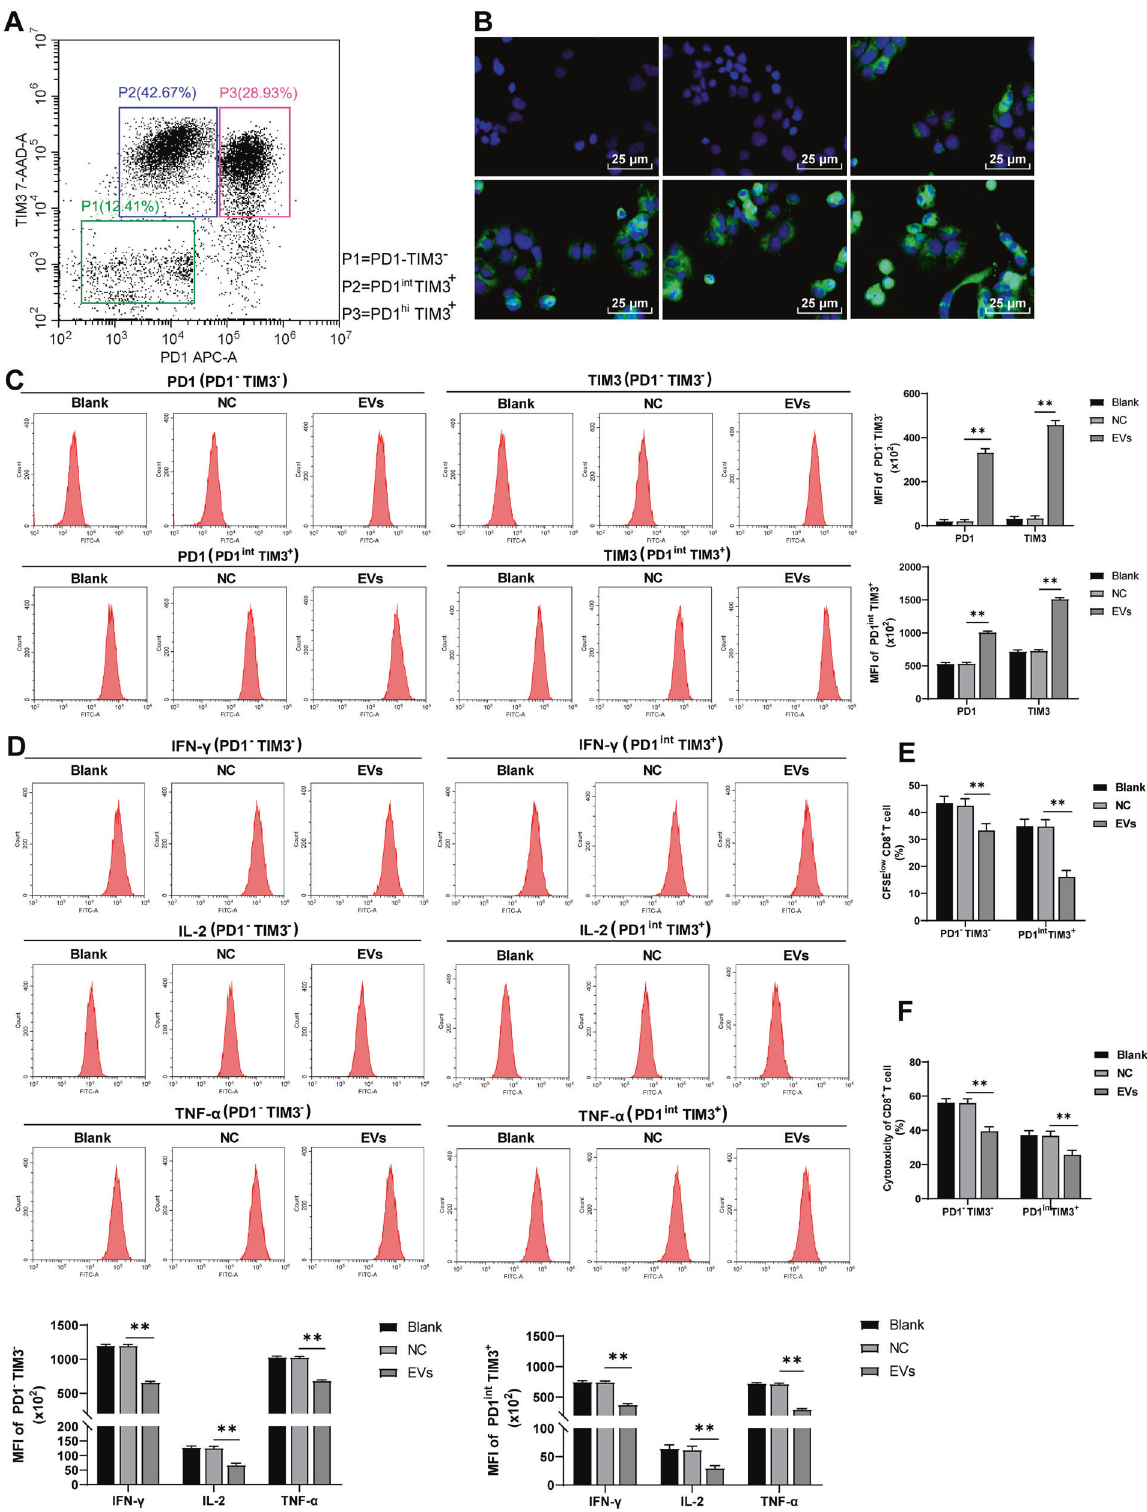
Fig. 3 EVs facilitated CD8 + T cell exhaustion. A The in fi ltrating CD8 + T cells sorted from HCC mice were divided into three groups: normal CD8 + T cells (PD1 - TIM3 - ), partially exhausted CD8 + T cells (PD1 int TIM3 + ), and completely exhausted CD8 + T cells (PD1 hi TIM3 + ). PKH67-labeled EVs were co-cultured with CD8 + T cells. B The absorption of EVs by CD8 + T cells was detected using immuno fl uorescence. C The expressions of inhibitory receptors in CD8 + T cell surface (PD1 and TIM3) were detected using fl ow cytometry. D The expressions of effector cytokines (IFN- γ , IL-2, and TNF- α ) were detected using fl ow cytometry. E The proliferation ability of CD8 + cells was measured using fl ow cytometry. F The ability of CD8 + cells to kill Hep1-6 cells was measured using fl ow cytometry. The cell experiment was repeated 3 times. Data are presented as mean ± standard deviation and analyzed using one-way ANOVA, followed by Tukey ’ s multiple comparison test, ** p < 0.01.